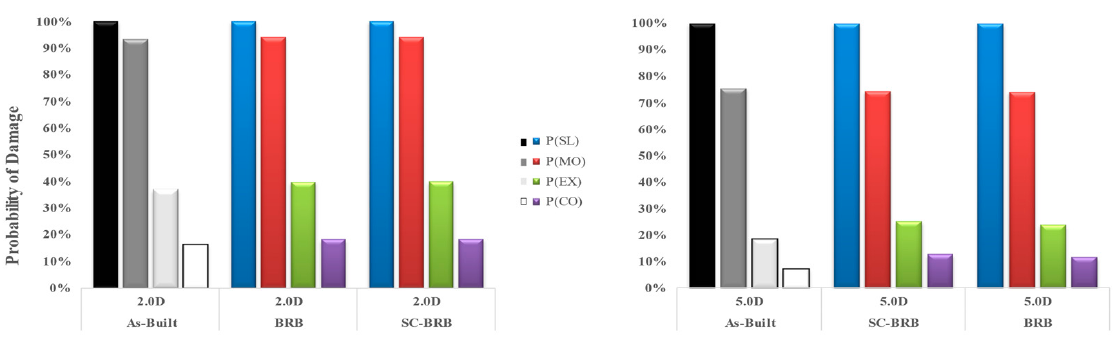
Figure 30. LSEPs of BD demands under far-field ( left , at 2D) and near-source ( right , at 5D) earthquake